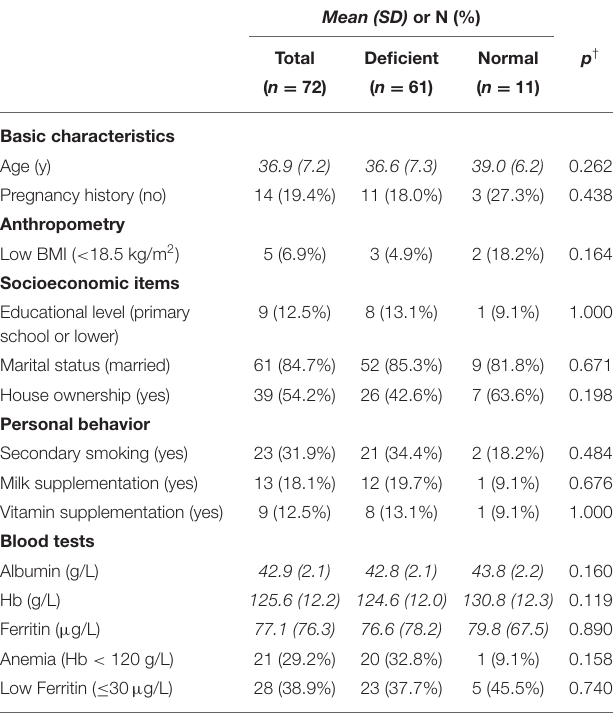
TABLE 1 | Zinc deficiency and associated